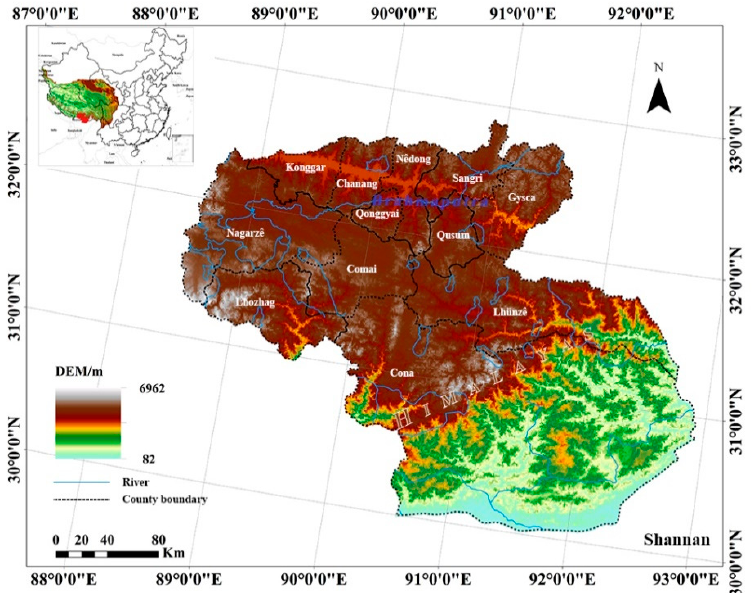
Figure 1. Location of study area.